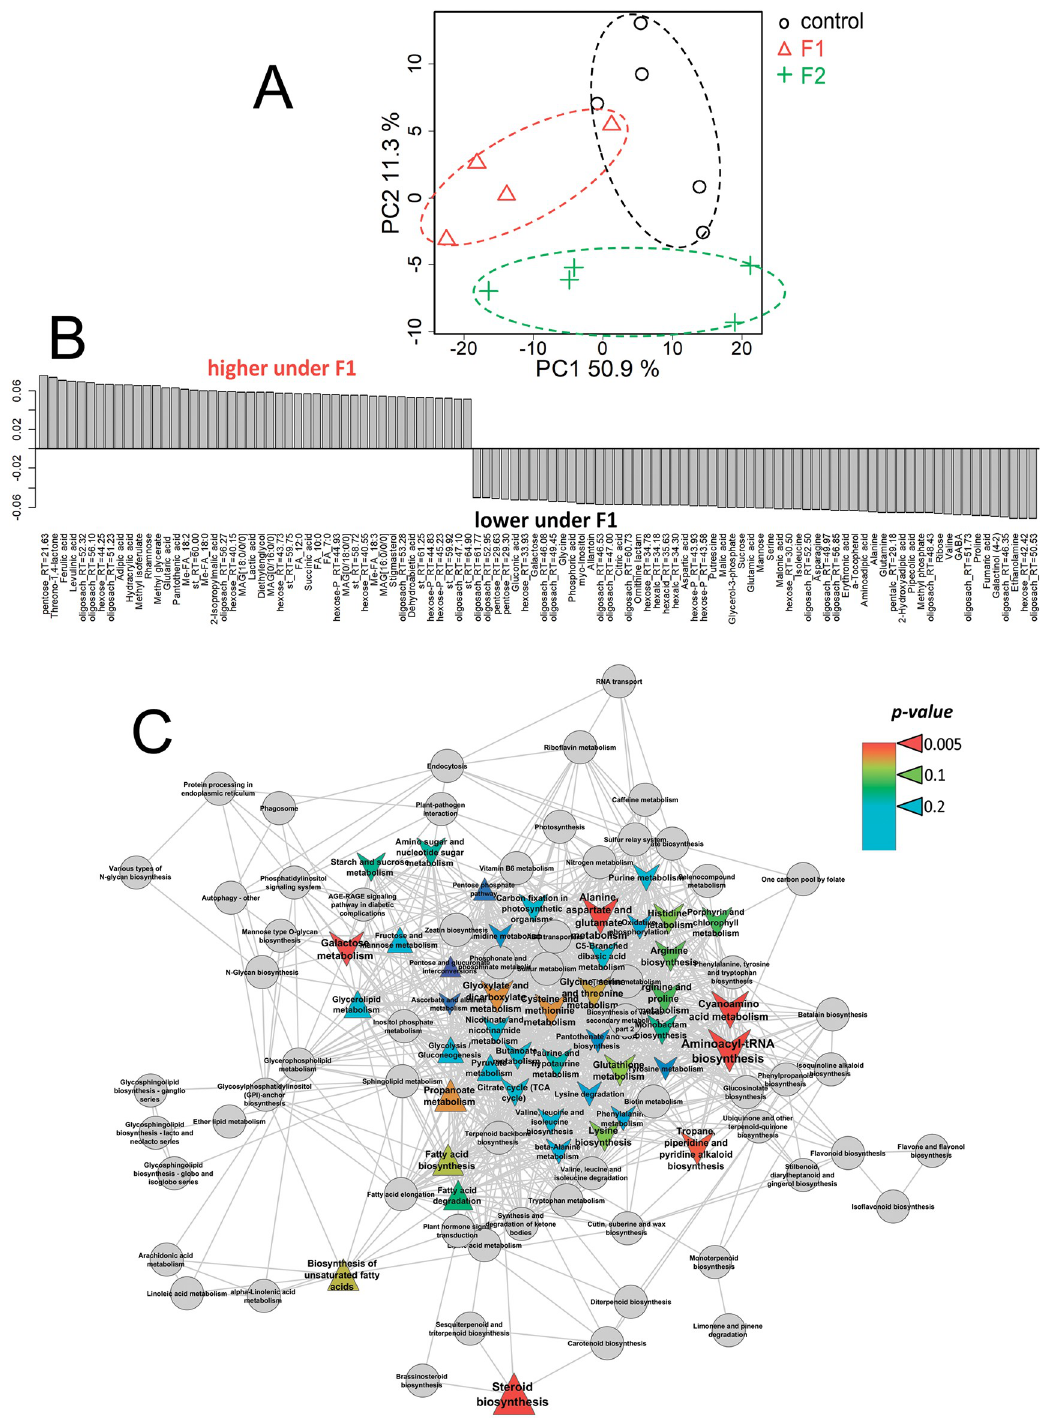
Fig 9. Fullerenols effects on leaf metabolome of the Fe III -deficient cucumber plants grown hydroponically in a nutrient solution with or without the supply of 1 (F1) mg L -1 fullerenol for 10 days. A—PCA score plot, B—Bar plots of loadings of predictive component (VIP > 1) derived from OPLS-DA, C—Enrichment analysis. Colours represent p- values, shapes: Δ — activation induced by F1 and v—repression by Fq, sizes—the power of effect represented as |NES|.